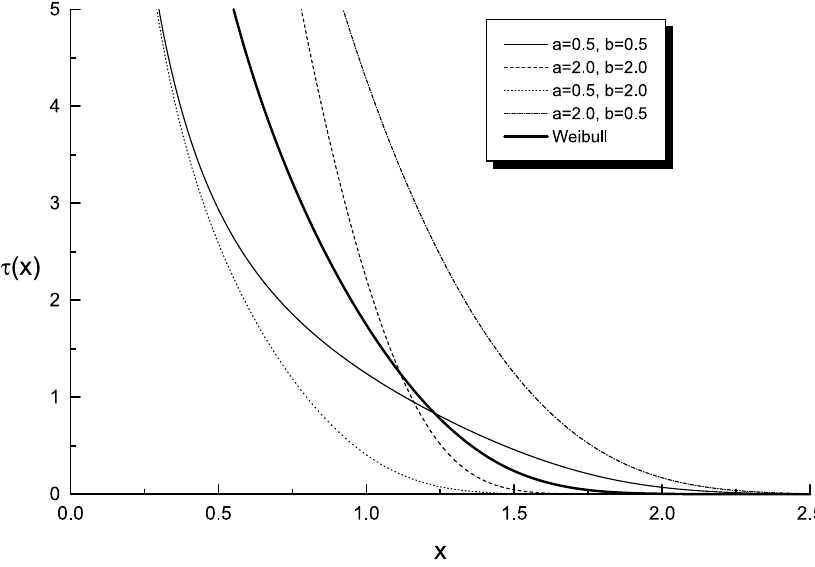
Fig. 2 – The BW hazard function (4) for selected values of parameters a and b